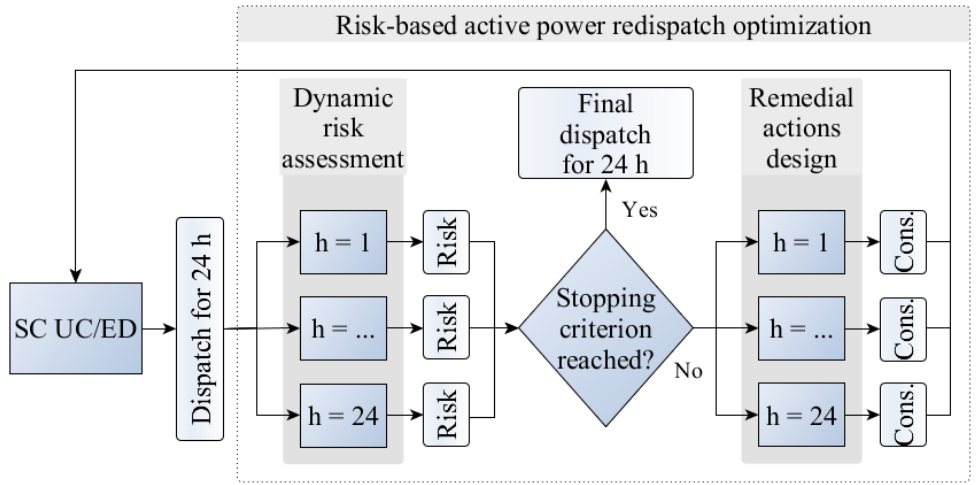
Figure 1. General scheme of the risk-based redispatch optimization method. The two main processes are shown as solid gray boxes, the subprocesses are depicted by dark blue ones, whereas the output data as light blue ones (this coloring scheme also applies to Figures 2 and